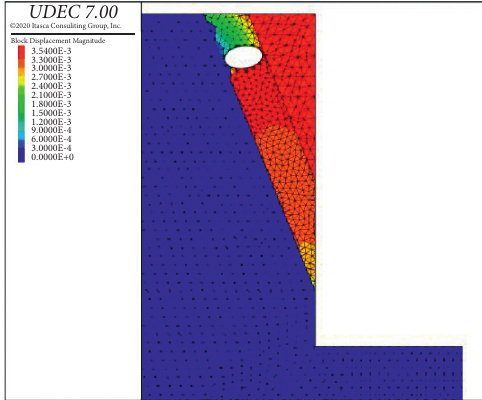
Figure 14: Displacement diagram of karst cave penetration failure.